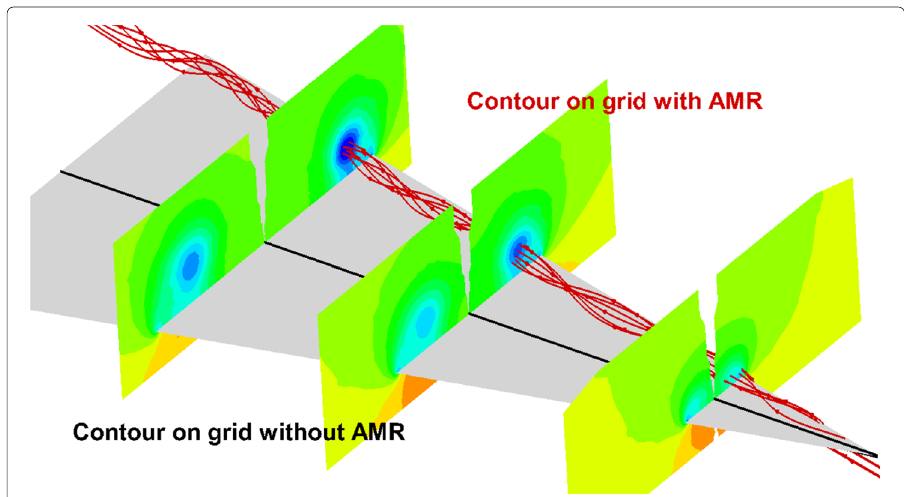
Fig. 30 Streamline and pressure contours on grids with AMR over the right half of the wing and grids without AMR over the left